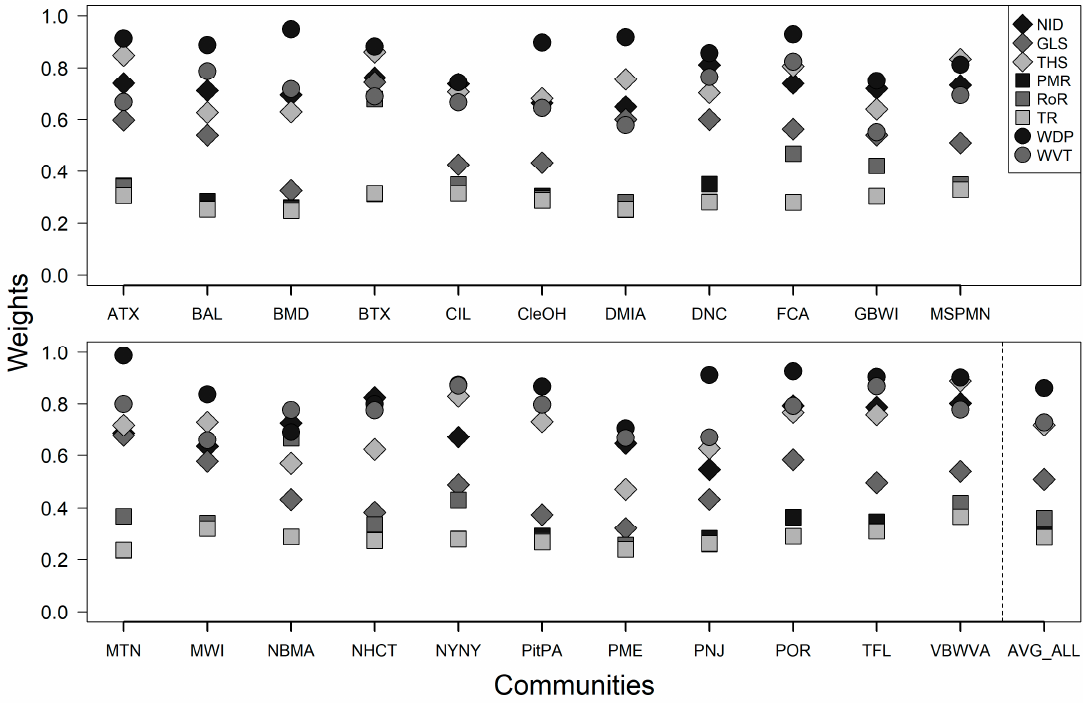
Figure 2. For all eight metrics in CEHI, weights were calculated for each of the 22 EnviroAtlas featured communities. The weights for each metric were also averaged across communities and are shown in the last column.